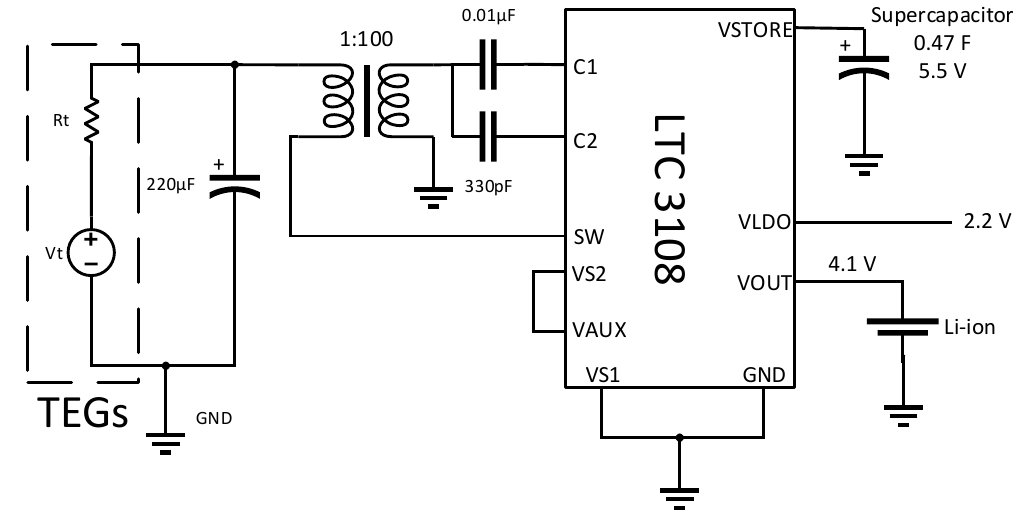
Figure 6. Schematic of thermoelectric energy harvesting circuit.